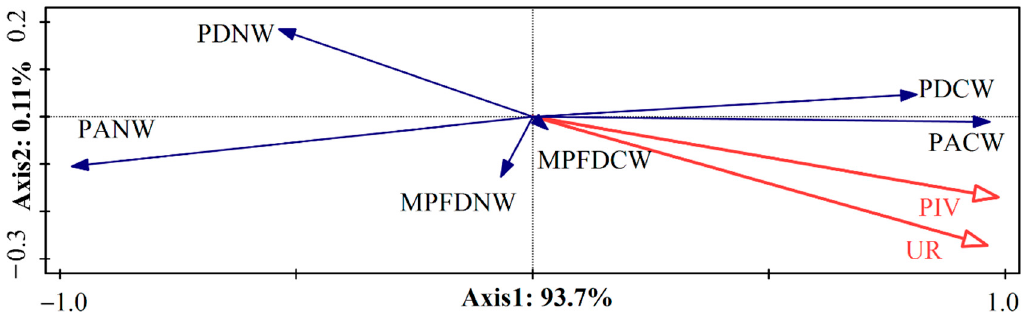
Figure 9. Coordination biplots of redundancy analysis (RDA) displaying the relationship between economic indicators and landscape metrics. Landscape metrics are response variables, and economic indicators are explanatory variables. The positive and negative correlation between two different indicators depends on the same or opposite direction of arrows, and the correlation is determined by the projection length of the arrows of two different indicators. PIV: primary industry value; UR: urbanization rate; PDCW: patch density of constructed wetland; PDNW: patch density of natural wetland; PACW: patch area of constructed wetland; PANW: patch area of natural wetland; MPFDCW: mean patch fractal dimension of constructed wetland; and MPFDNW: mean patch fractal dimension of natural wetland. Table 5. Correlation analysis of wetland landscape and economic indicators.